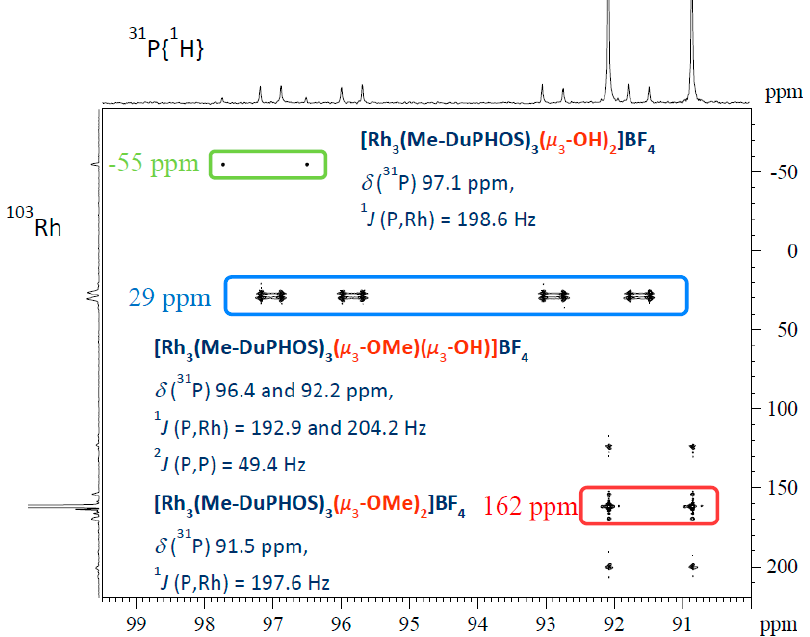
Figure 19. 31 P{ 1 H}- 103 Rh HMQC spectrum in MeOH- d 4 of the trinuclear species arising from treatment of [Rh(Me-DuPhos)(MeOH) 2 ]BF 4 with NEt 3 /H 2 O (1:1) [195].